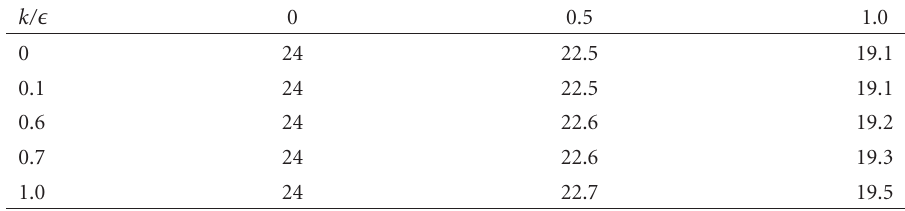
Table 6.1. Critical values of E c P r for the reversal of heat flux at the hotter wall when σ = 10, λ 1 = 0 . 1. k/ (cid:1) 0 0.5